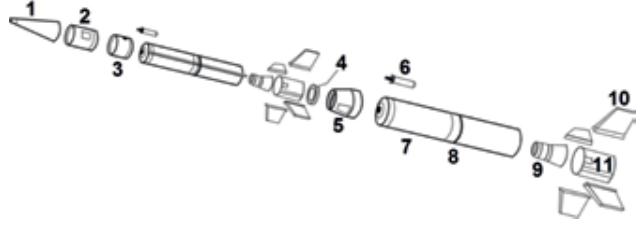
Figure 1. Exploded view of the SIII rocket from IAE, as adapted from Palmério